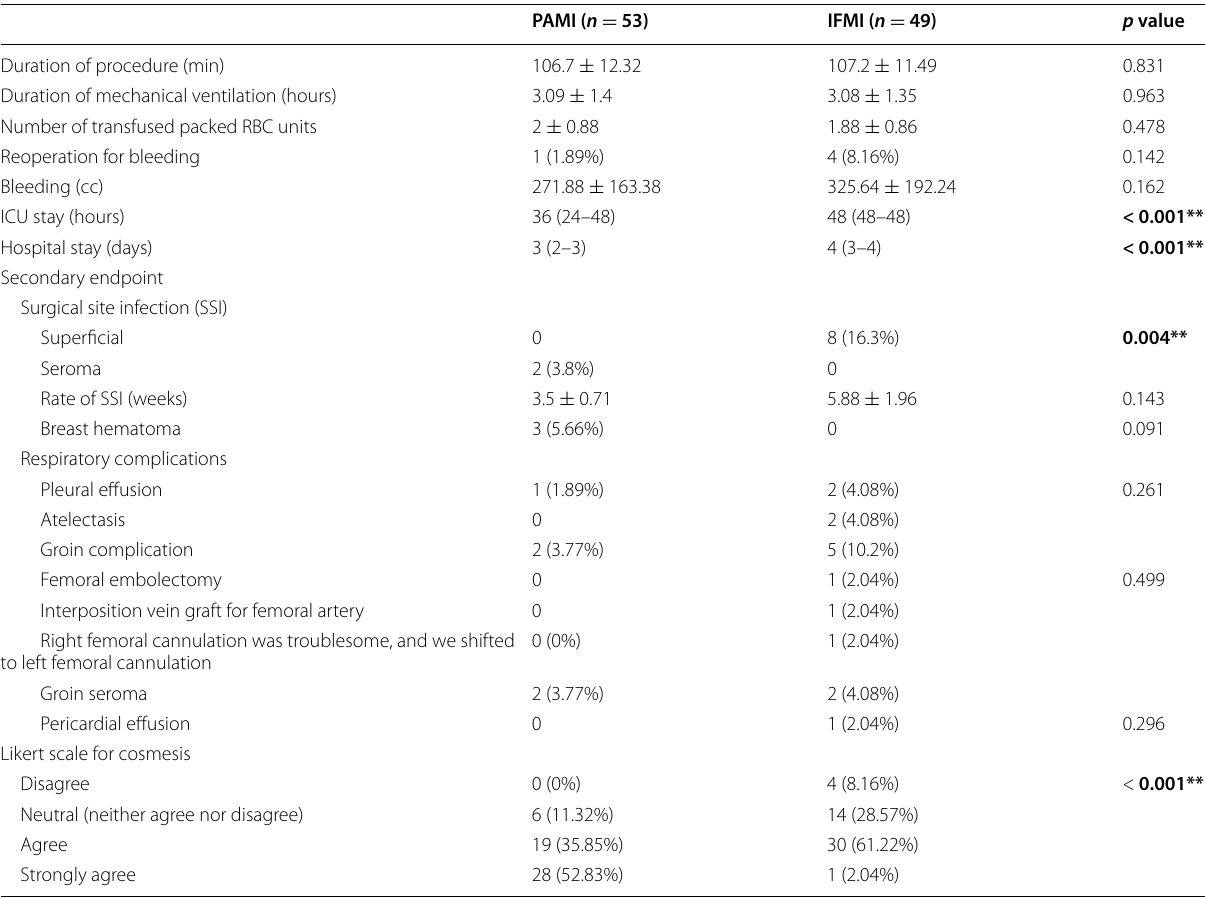
Table 4 Primary and secondary endpoints of our PAMI trial